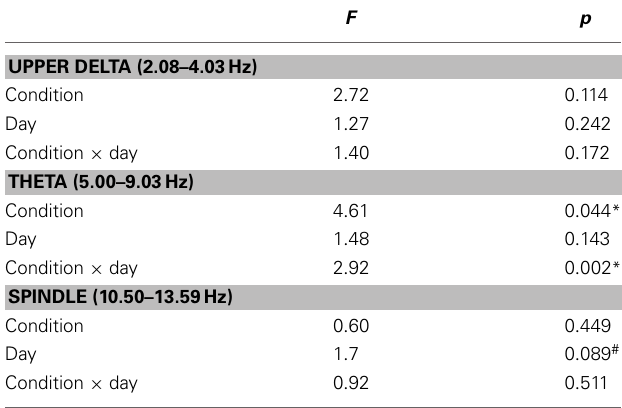
Table 3 | F-statistics for EEG power during acute